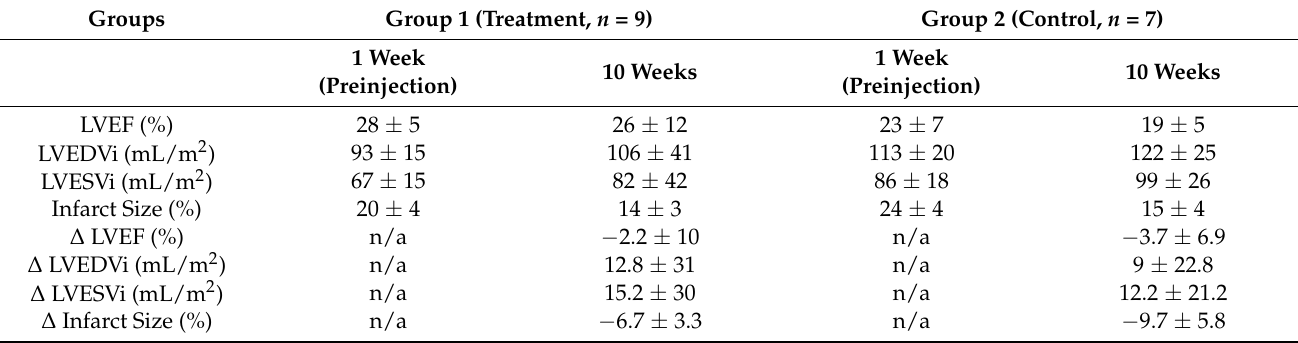
Table 2. Main cardiac parameters calculated from CMR exams performed throughout the study.